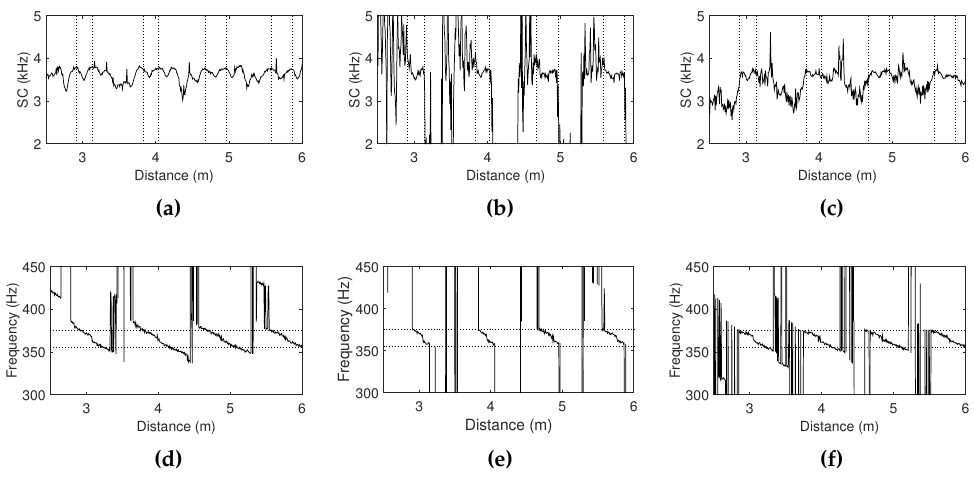
Figure 10. Approximations of spectral centroids and resonant frequencies from the simulated feedback signals when the cutoff frequency of the low-pass filter is ( a , d ) constant and ( b , e ) controlled with the proportional mapping and ( c , f ) reflected mappings. Vertical dot lines in the upper figures represent the positions where the approximated resonant frequencies deviate from the thresholds. These thresholds are depicted as the horizontal dot lines in the lower